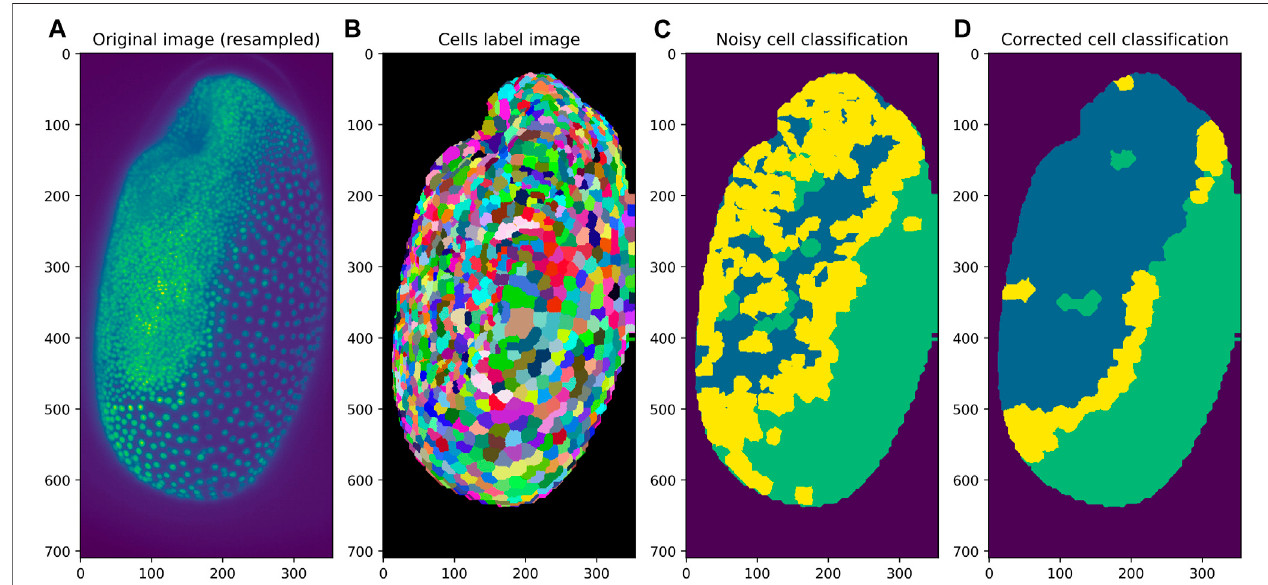
FIGURE 4 | Application of the mode fi lter to a classi fi cation result of cells in a developing Tribolium castaneum embryo. Starting from a given 3D image dataset (A) and a label image representing the cell segmentation (B) , cells can be classi fi ed into three classes. If the classi fi cation is noisy (C) , application of the mode of proximal neighbors fi lter can be used to determine the most popular class in each cell ’ s neighborhood (D)